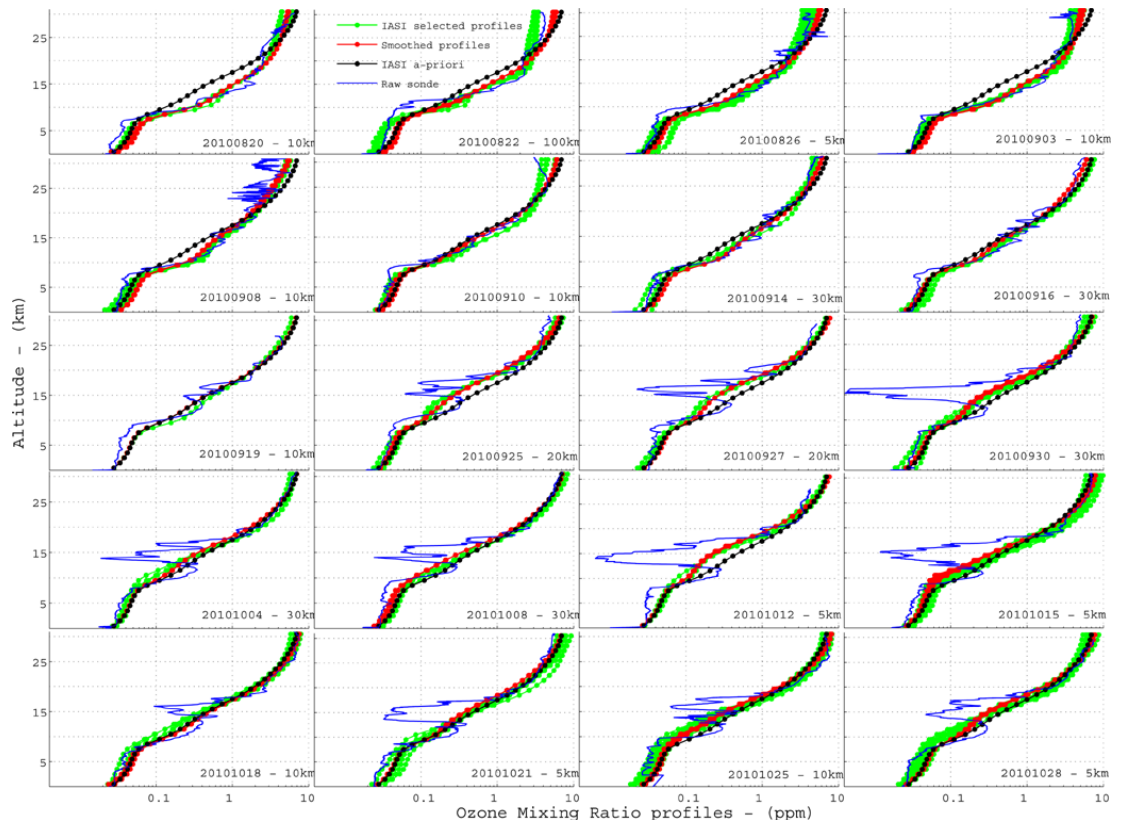
Fig. 5. Comparison between the high-resolution raw ozonesonde profile (blue), the low-resolution smoothed ozonesonde profiles (red) and the low-resolution IASI/MetOp ozone profiles (green). Note that the graphs use logarithmic x-scale. Collocation criteria are given in each plot next to the